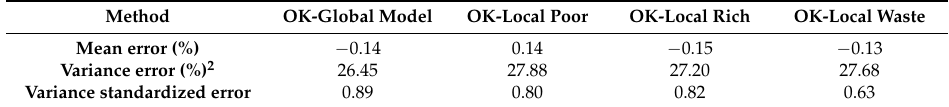
Table 5. Cross-validation comparison using global models and local model with adjacent domain data.